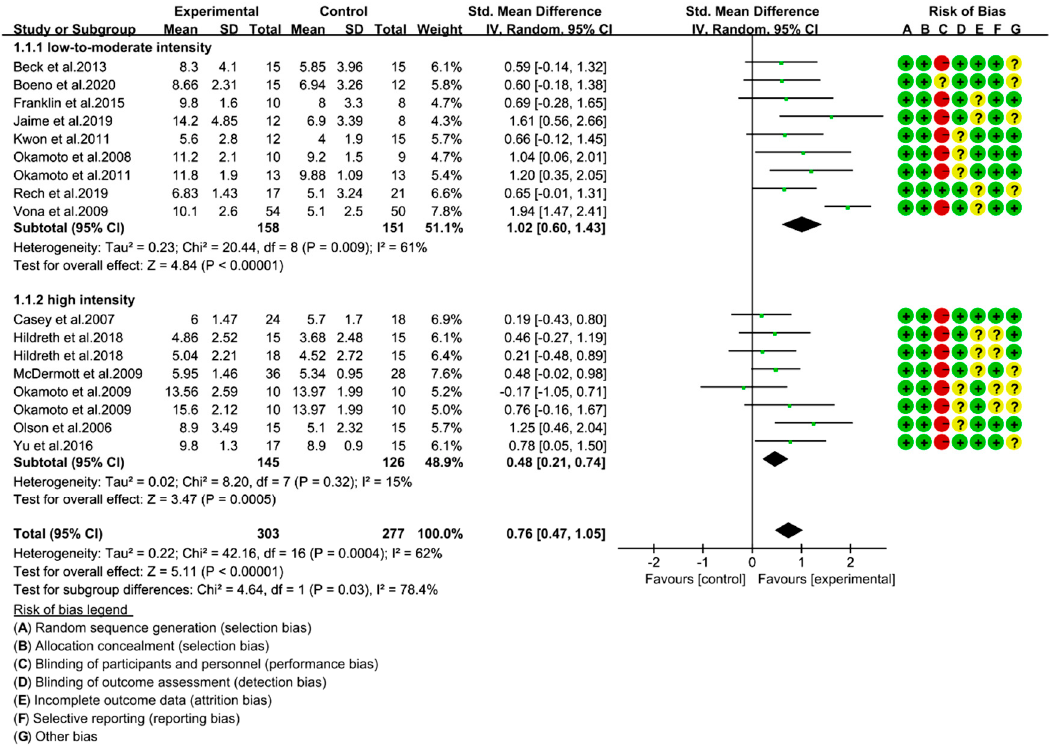
Figure 2. Forest plot of the brachial artery FMD change with different intensities of RE (%). Risk of bias; low risk of bias (+ green), high risk of bias ( − red), and unclear risk (? yellow).